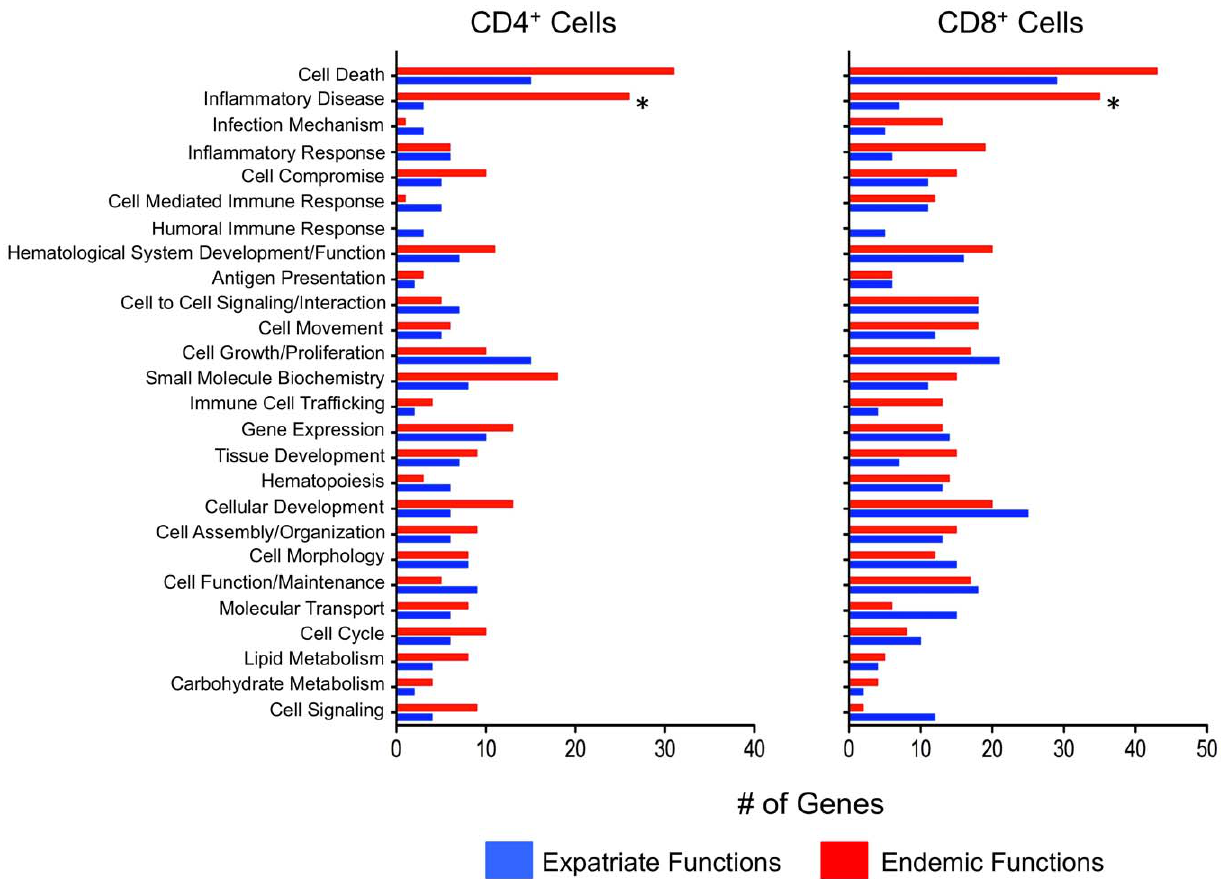
Figure 3. Functional analysis of genes in unstimulated cells. Number of genes associated with specific cellular functions in the unstimulated CD4 + (left panel) and CD8 + (right panel) T cells of Loa loa infected endemic (red bars) and expatriate (blue bars) patients. Annotation for cell functions was extracted from www.ingenuity.com using genes that were differentially expressed at p , 0.01 and adjusted for multiple comparisons using the Benjamini Hochberg False Discovery Rate (FDR) correction.